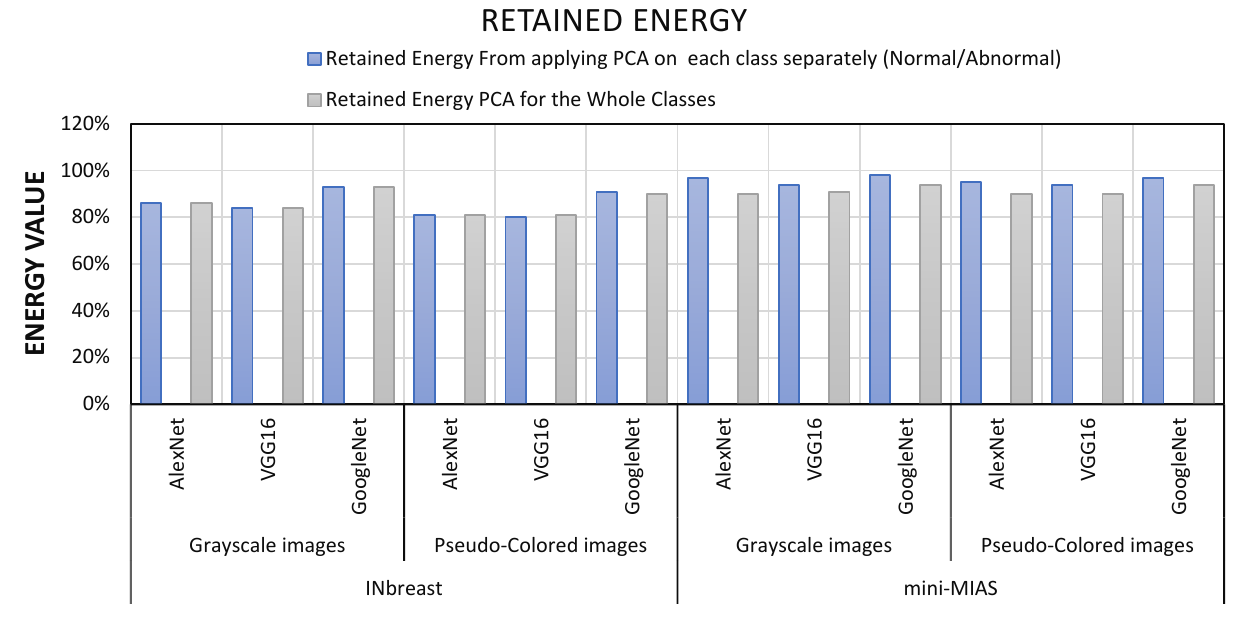
Figure 6. The energy retained within the retrieved PCs.